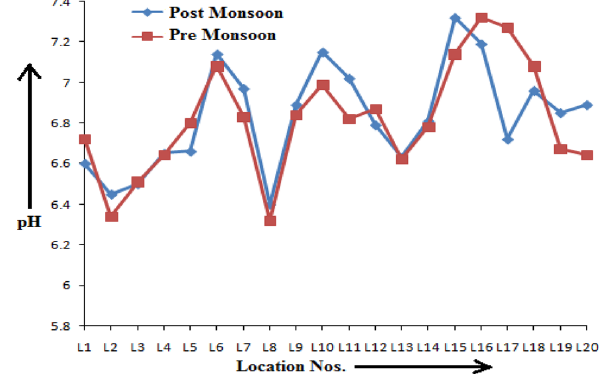
Fig. 3 Spatio-temporal variation in pH value in the study area